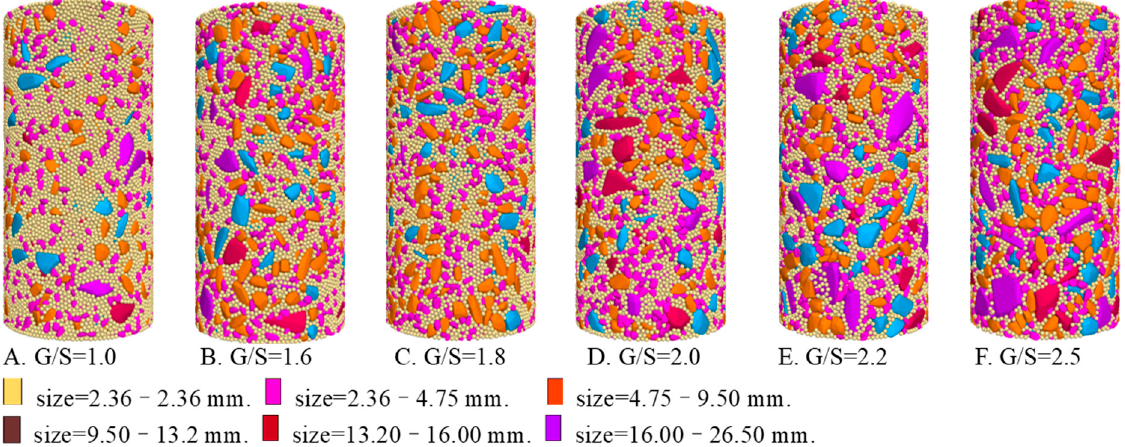
Figure 10. The compacted DEM specimens with different G/S levels.